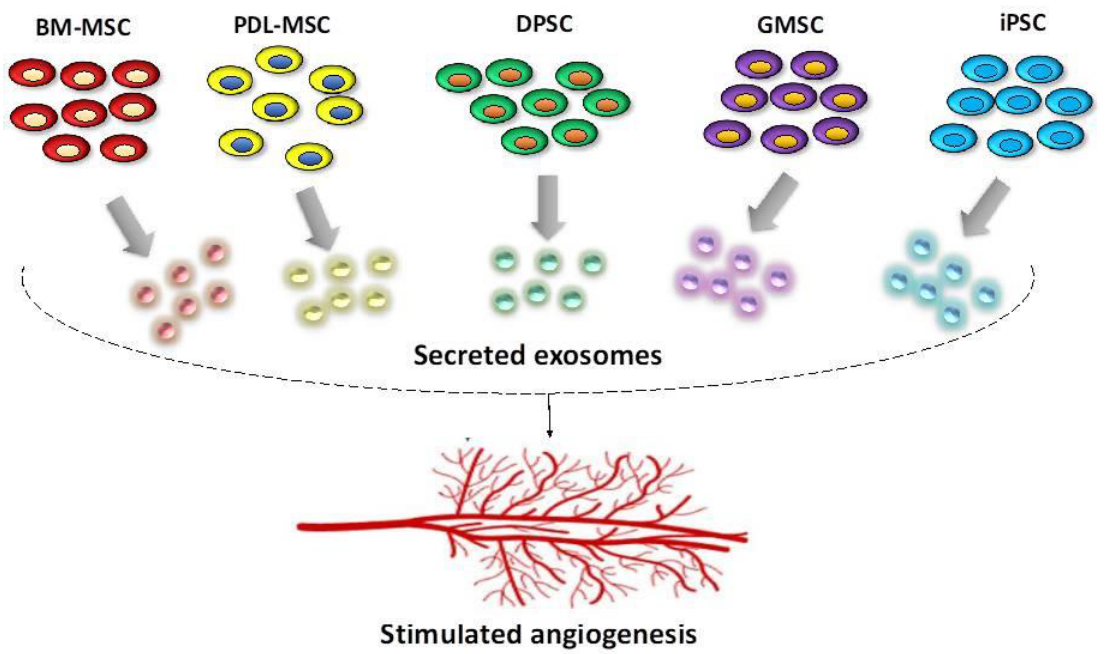
Figure 2. There are multiple stem cells types, which can, through their secreted exosomes, lead to stimulated angiogenesis. In dentistry, there are five main types of stem cells most often evaluated for their general regenerative potential as well as their pro-angiogenic capacity; these are: the bone marrow derived mesenchymal stem cells (BM-MSC), the periodontal ligament stem cells (PDL-MSC), dental pulp stem cell (DPSC), gingival mesenchymal stem cells (GMSC), and induced pluripotent stem cells (iPSC).